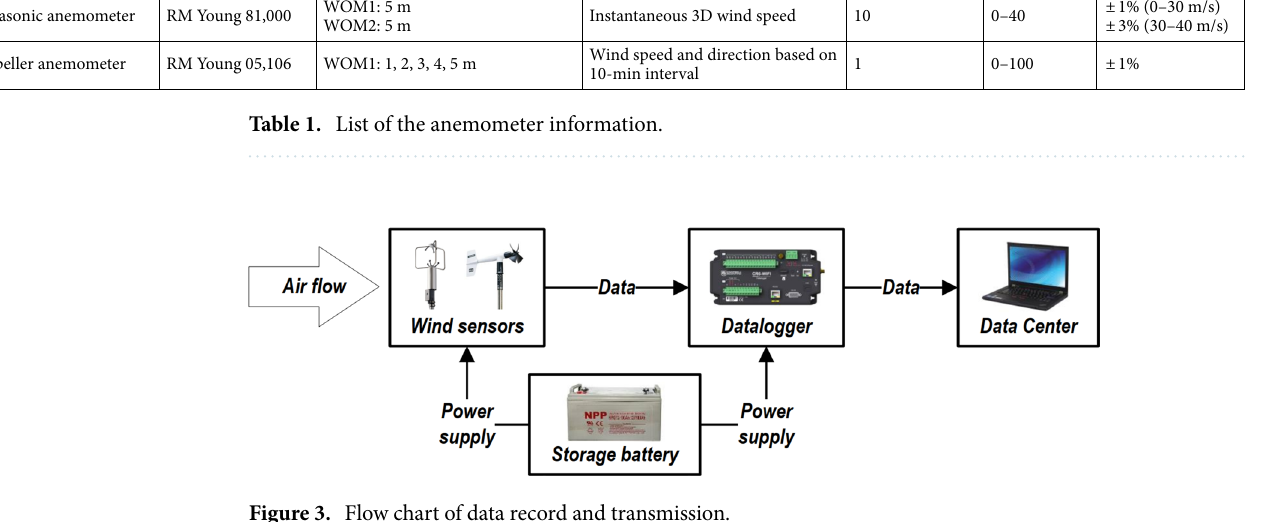
Figure 3. Flow chart of data record and